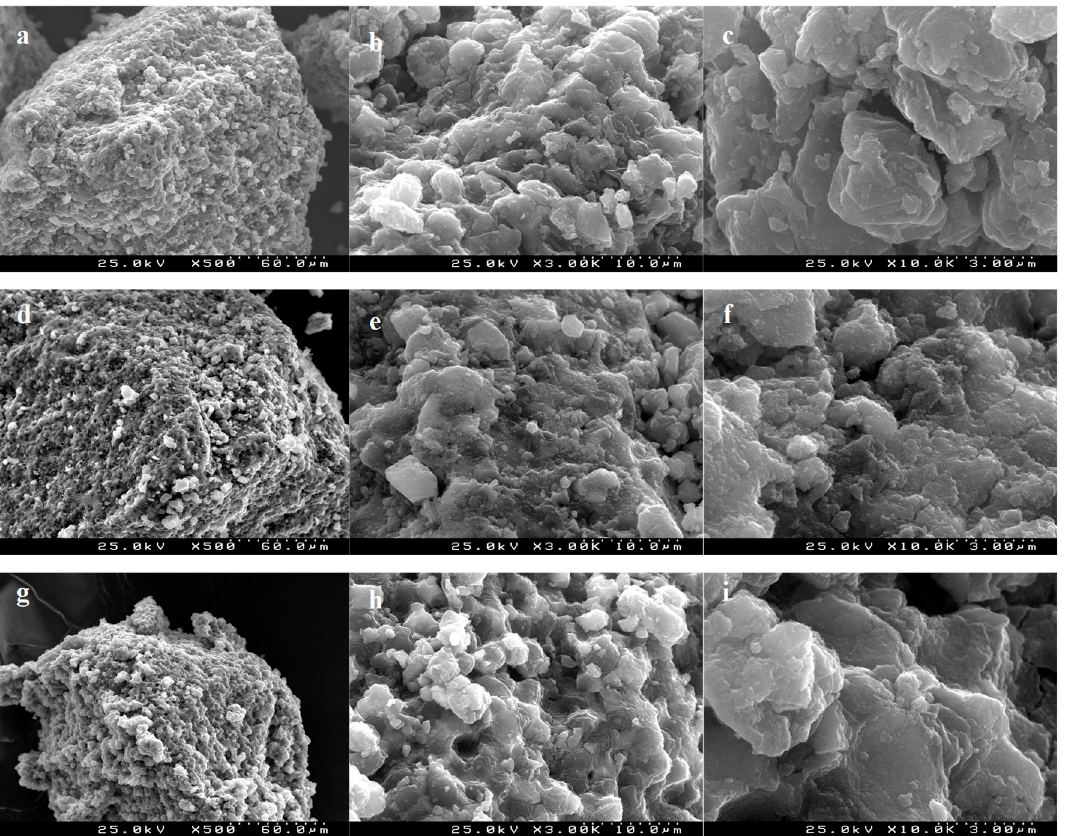
Figure 5. Scanning electron microscopy (SEM) images of MY ( a ), ( b ), ( c ), MY@NIPs ( d ), ( e ), ( f ), and MY@MIPs ( g ), ( h ), ( i ).